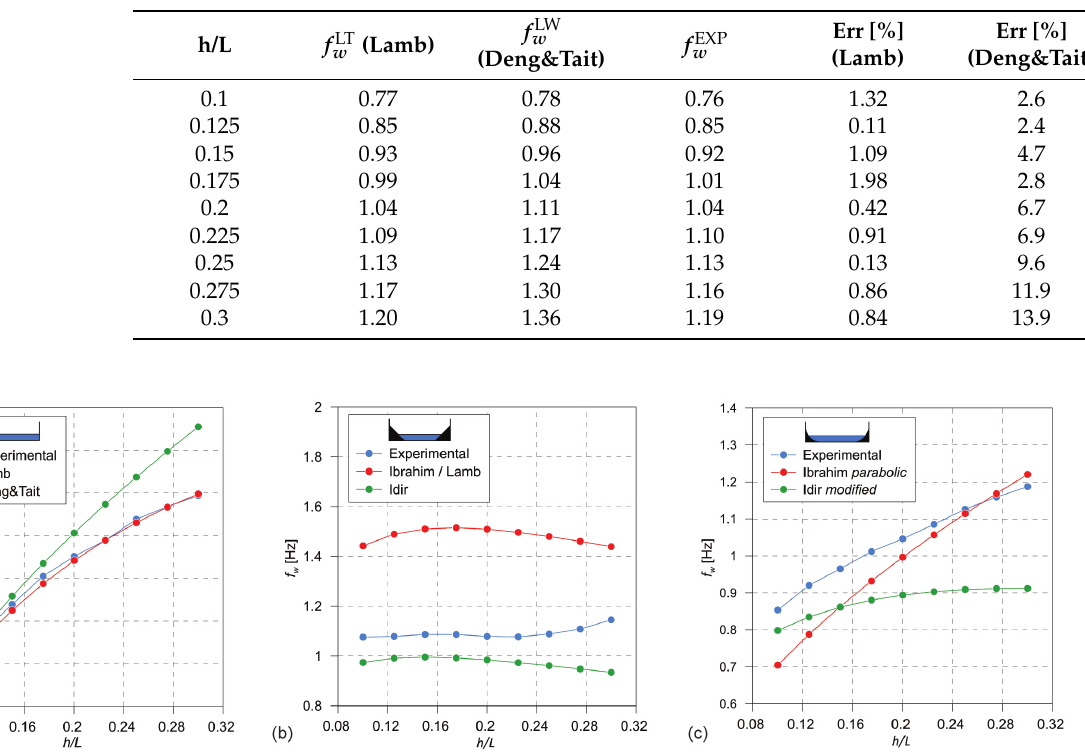
Figure 7. Comparison between analytical and experimental natural sloshing frequencies for flat ( a ), sloped ( b ) and circular ( c ) bottom